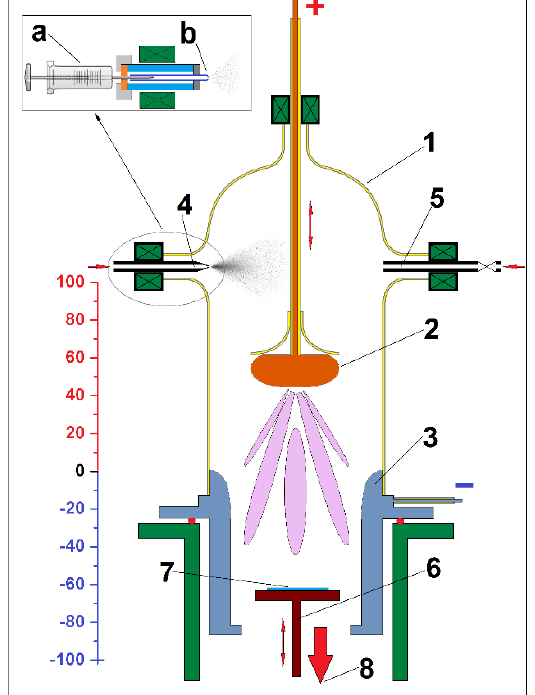
Figure 1. Schematic representation of the DC plasma reactor ( 1 —glass reaction chamber; 2 —anode; 3 —cathode; 4 —precursor injection system; 5 —gas injection system; 6 —substrate holder; 7 —substrate (Si wafer); 8 —exhaust of chemical vacuum pump). In the inset is the precursor injection system ( a —microliter syringe; b —spray nozzle).